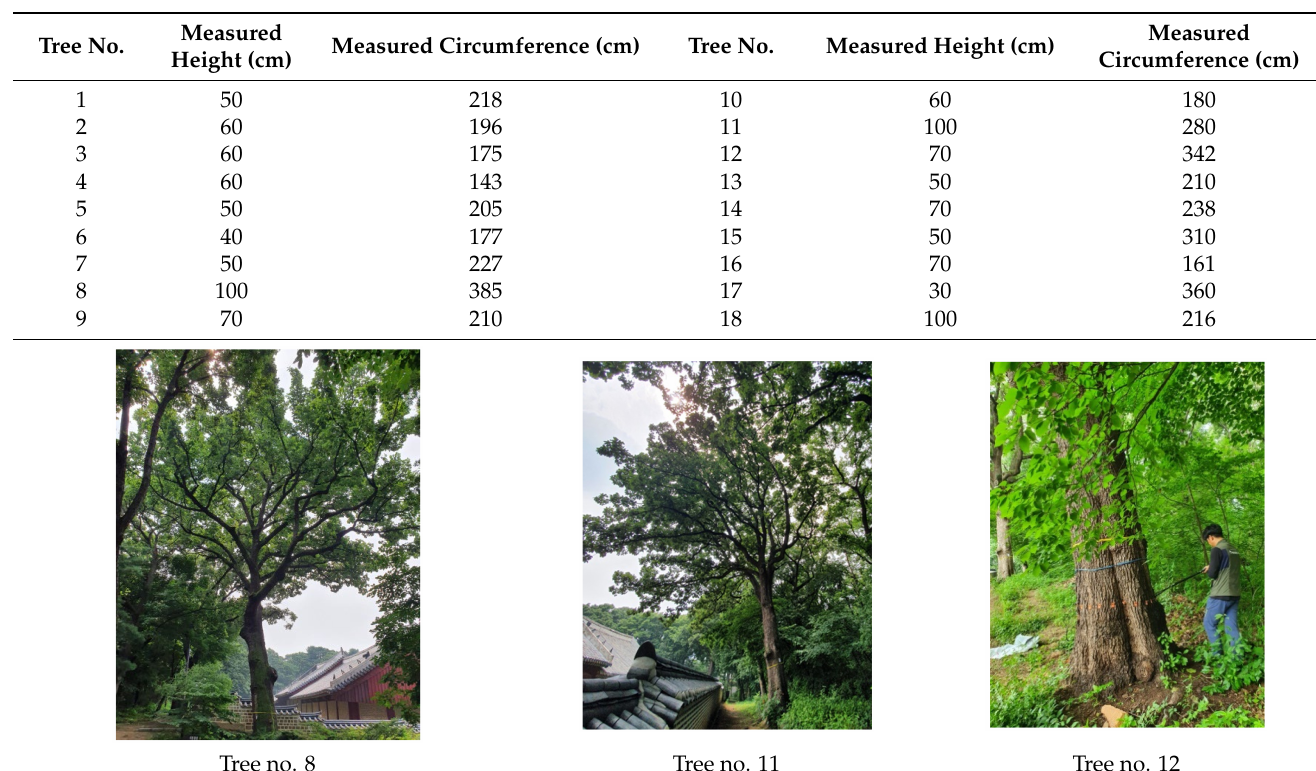
Table 2. Basic information of the defective trees using SoT.